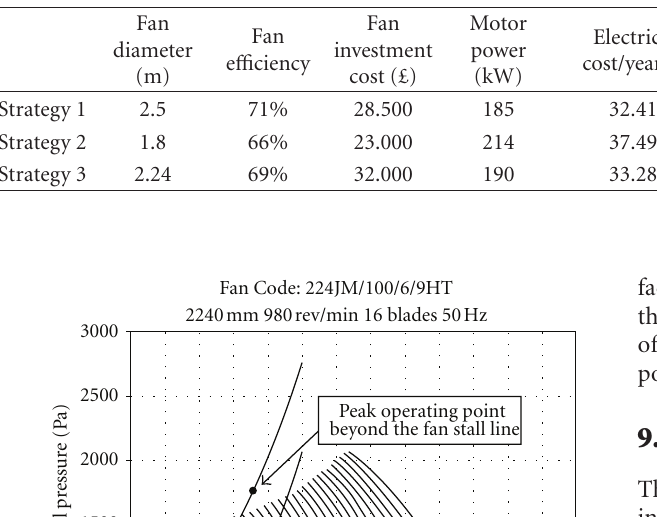
Table 5: Capital cost and ten year though life cost of each selection strategy.